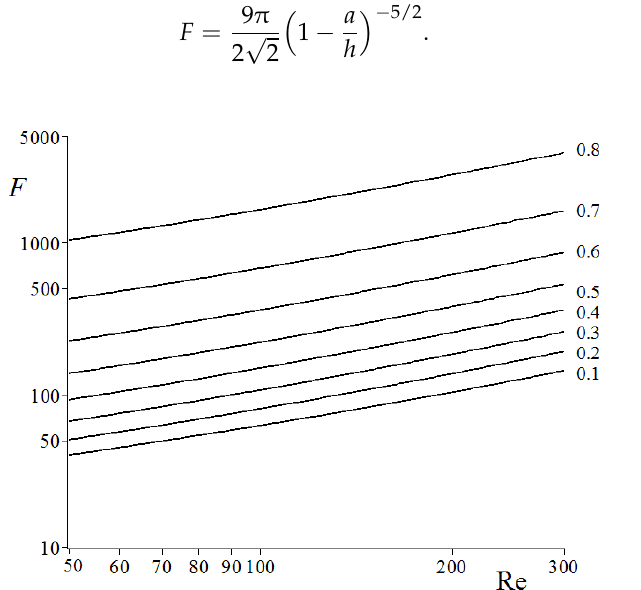
Figure 2. The fiber drag force in a row of fibers vs. the Reynolds number: in the case of intermediate Figure 4. The fiber drag force in a row of fibers vs the Reynolds number: in the case of intermediate Reynolds numbers, the a / h values are marked on the Reynolds numbers, the ha values are marked on the curves.